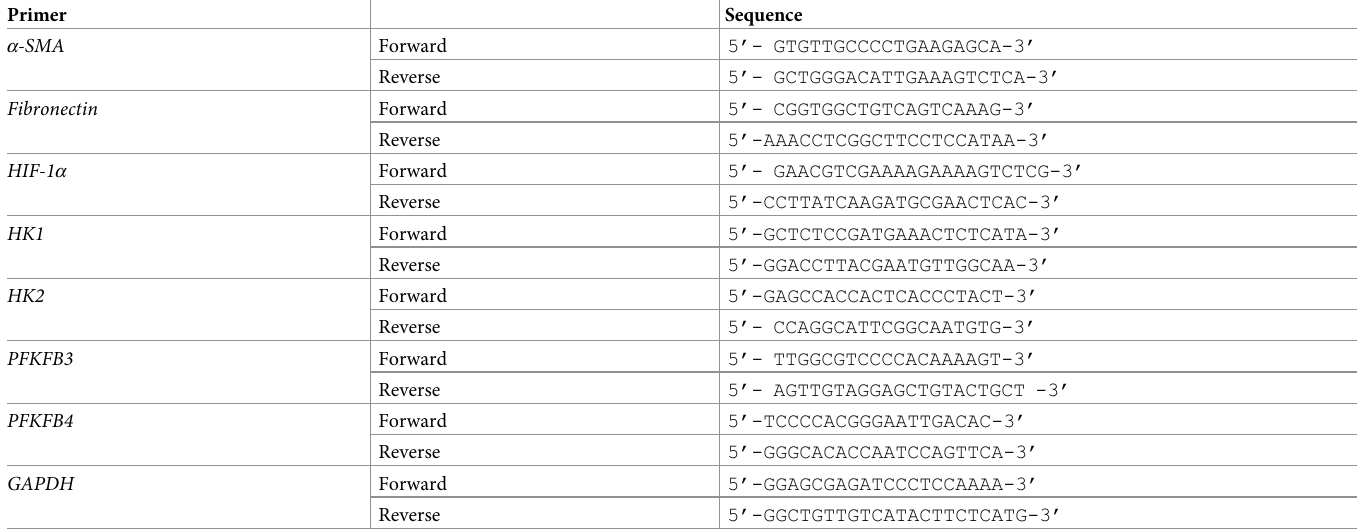
Table 2. Sequences of real time-PCR oligonucleotide primers.